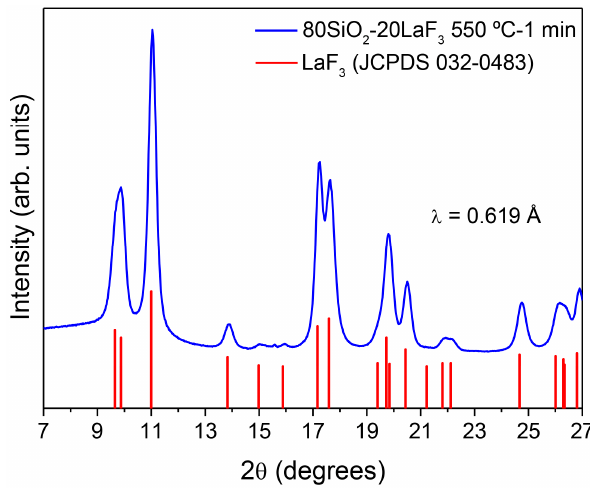
Figure 9. XRD of 80SiO 2 -20LaF 3 GC treated at 550 °C for 1 min performed at the synchrotron SpLine BM25B of the ESRF.